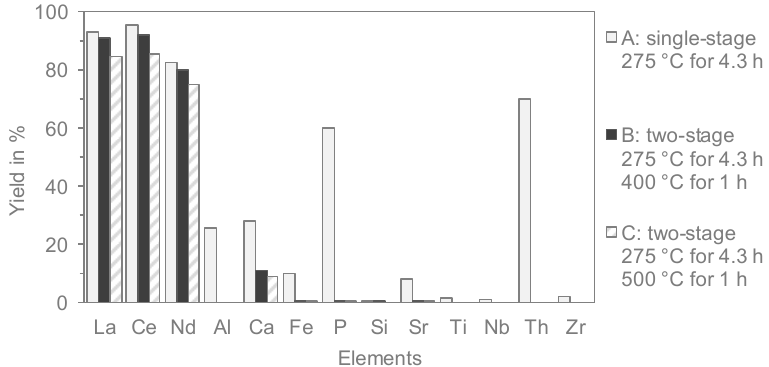
Figure 16. Yield of elements after digestion with concentrated sulfuric acid. In all experiments, the concentrated ratio of sulfuric acid to REO was 6. In Experiment A, a single-stage digestion was executed. In Experiments B and C, a second temperature stage was added. After digestion, the cake was leached with water at a S:L ratio of 10 for 1 h at room temperature.